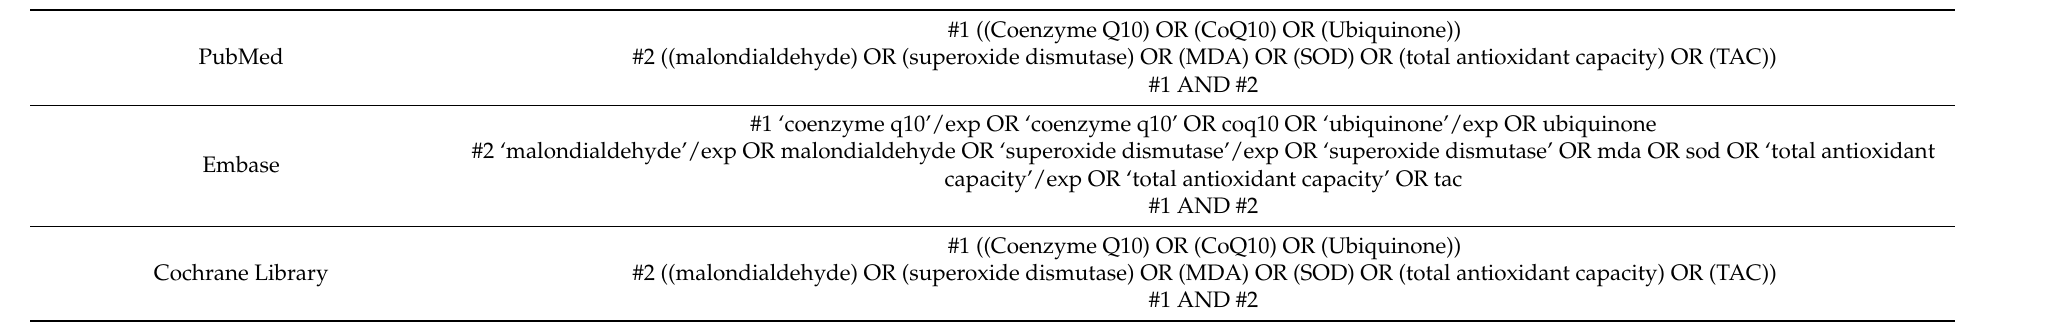
Table A1. Search strategy. For all databases, searches were performed for the time period until 30 March 2022.